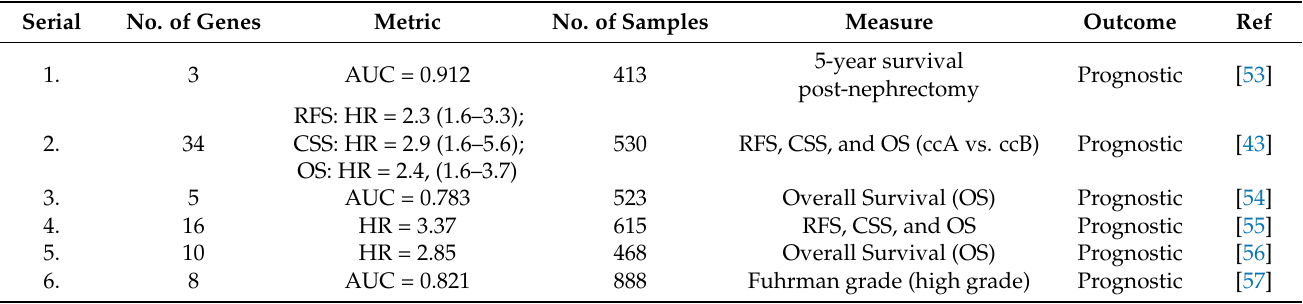
Table 3. List of gene expression studies for diagnostic (ccRCC vs. normal tissue), prognostic (overall survival, recurrence, disease-free survival, and cancer-specific survival), and therapeutic